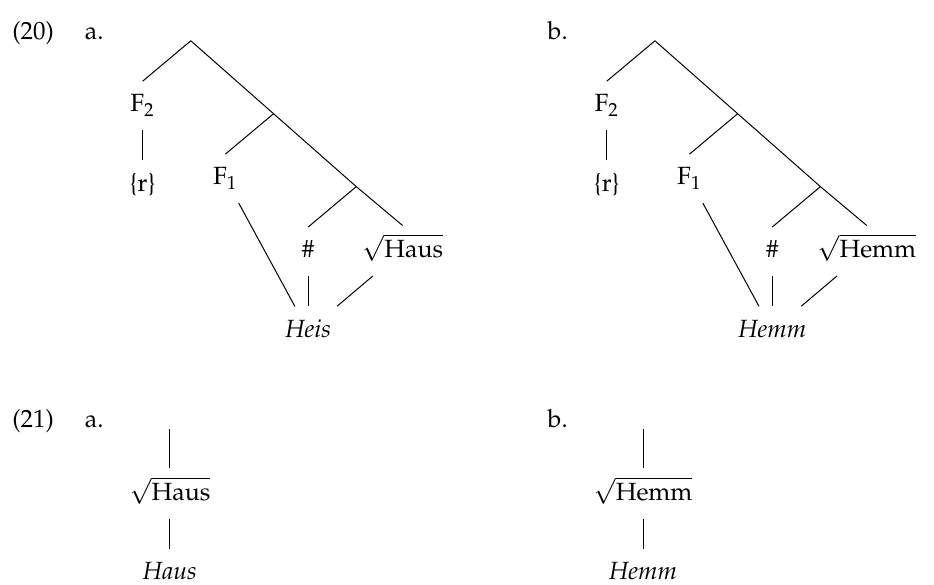
√ root and plural exponents.